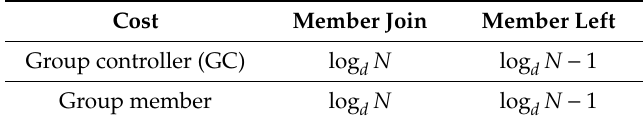
Table 1. Computation cost of computation-e ffi cient group-key distribution (CEGKD) under Method